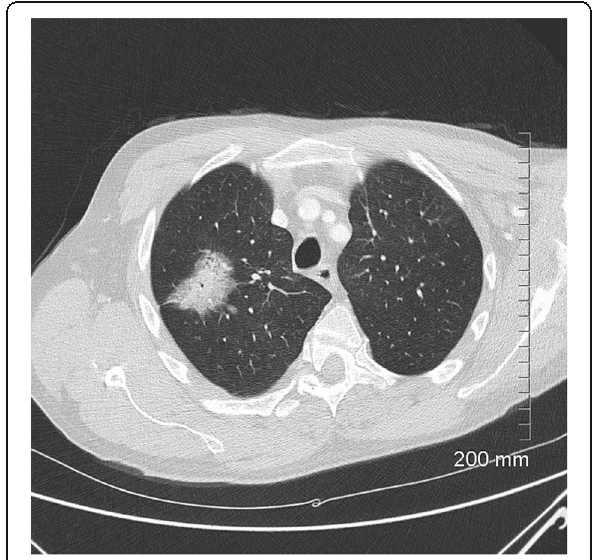
Fig. 10 Lepidic predominant adenocarcinoma on CT. The 4.2 cm mass in the right upper lobe has spiculated margins, cystic lucencies, air bronchograms and satellite